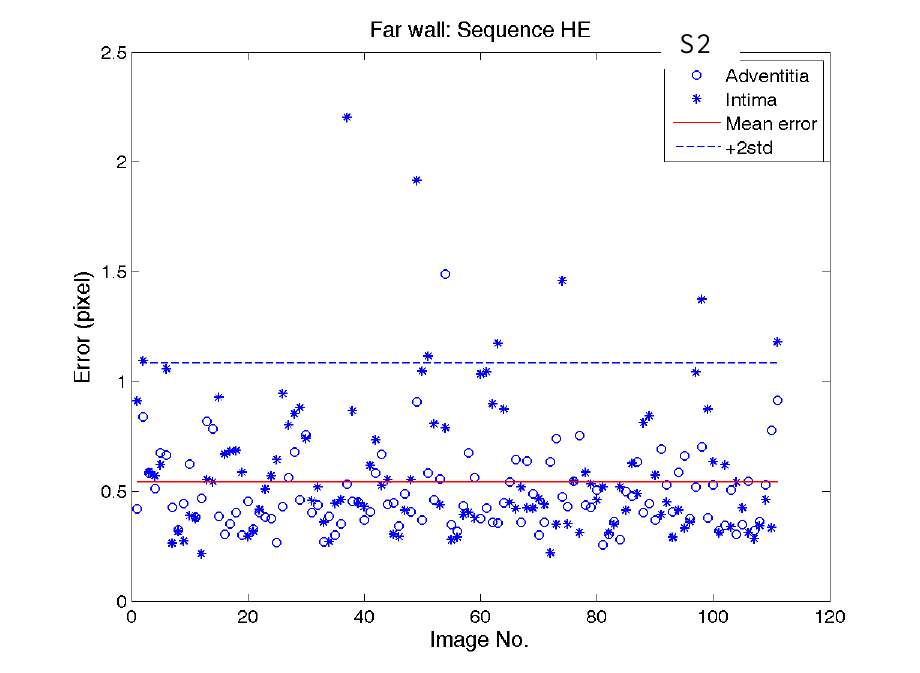
Figure 13. ―*‖ and ―o‖ denote the far wall error distribution of intima and adventitia along image number, respectively. The total averaged error of the far wall is 0.54-pixel in sequence S2.